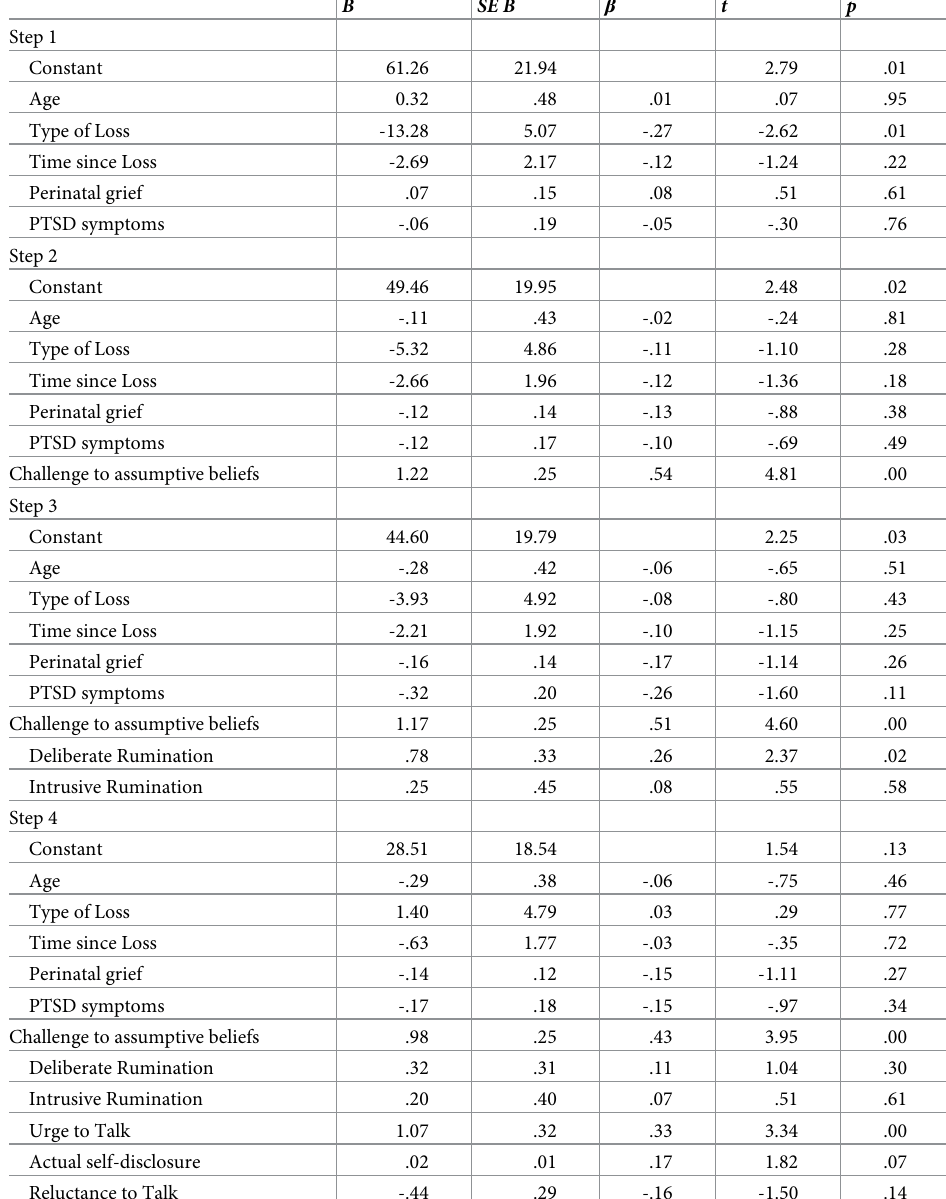
Table 4. Multiple regression analysis with posttraumatic growth as dependent